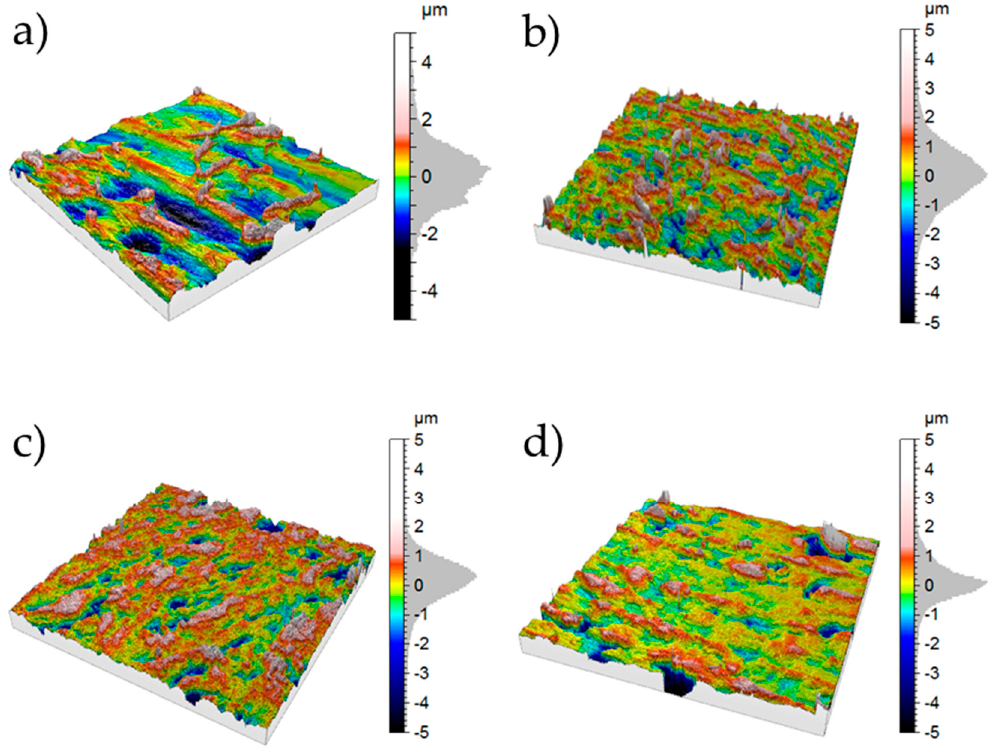
Figure 9. 3D surface mapping of ( a ) pure PP; ( b ) PP/20; ( c ) PP/40 and ( d ) PP/80. Table 4. Surface roughness expressed using 2D profile and 3D surface factors.